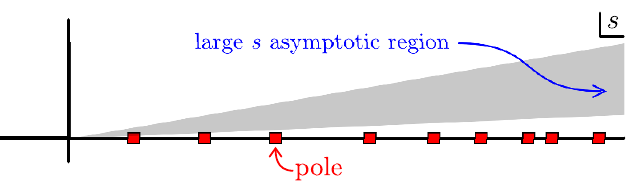
Figure 3 . The large s asymptotic region where we defined the asymptotic distribution of excess zeros ρ